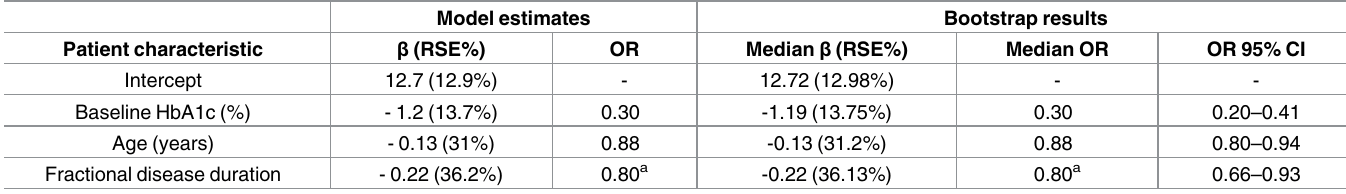
Table 3. Parameterestimates,regression coefficients and odds ratios with the 95% CI of the final multivariable logistic regression model and bootstrap results (n =